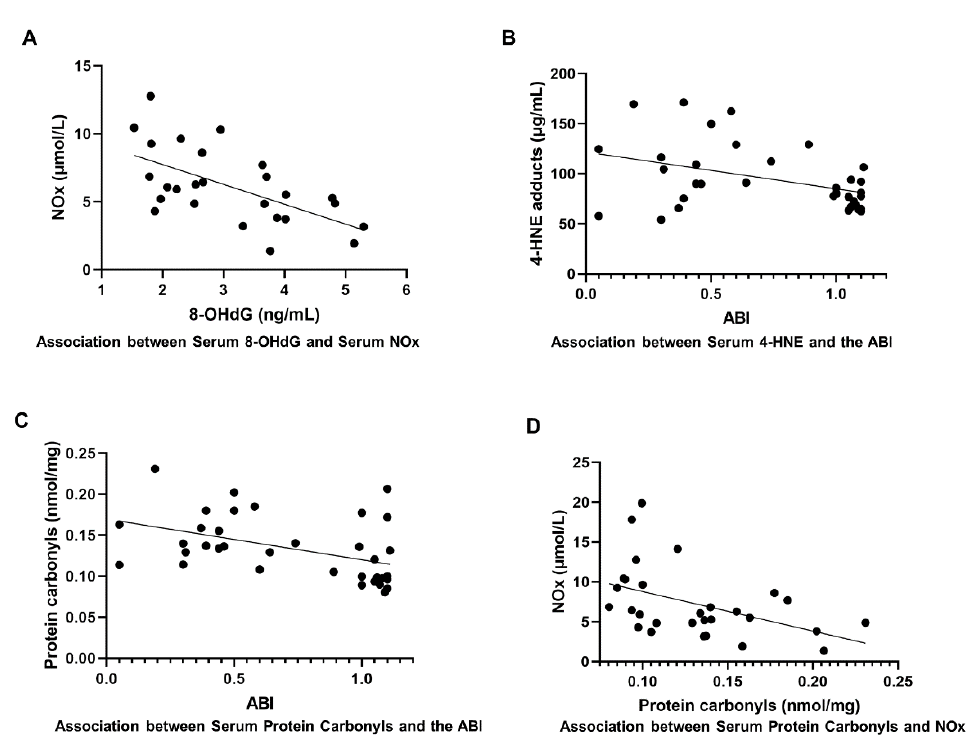
Figure 3. Associations between oxidative stress markers with nitric oxides (NOx) and ankle-brachial index (ABI). A Pearson correlation was calculated to test the association between variables. ( A ), There was a significant association between 8-OHdG and NOx levels (r = −0.602, p = 0.001); ( B ), 4- hydroxynonenal (4-HNE) levels and the ABI (r = −0.409, p = 0.015); ( C ), protein carbonyl levels and the ABI (r = −0.439, p = 0.007); and ( D ), protein carbonyl and NOx levels (r = −0.457, p = 0.013).